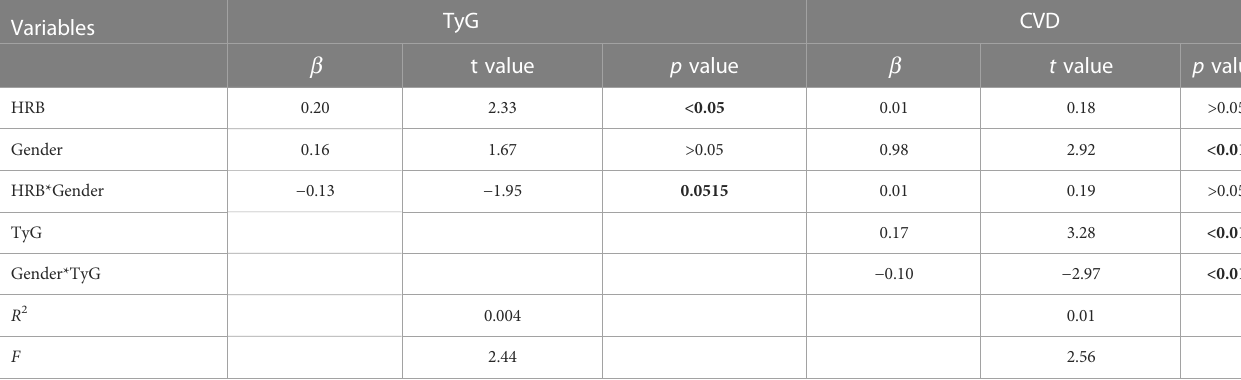
TABLE 8 Model characteristics for the conditional process analysis.